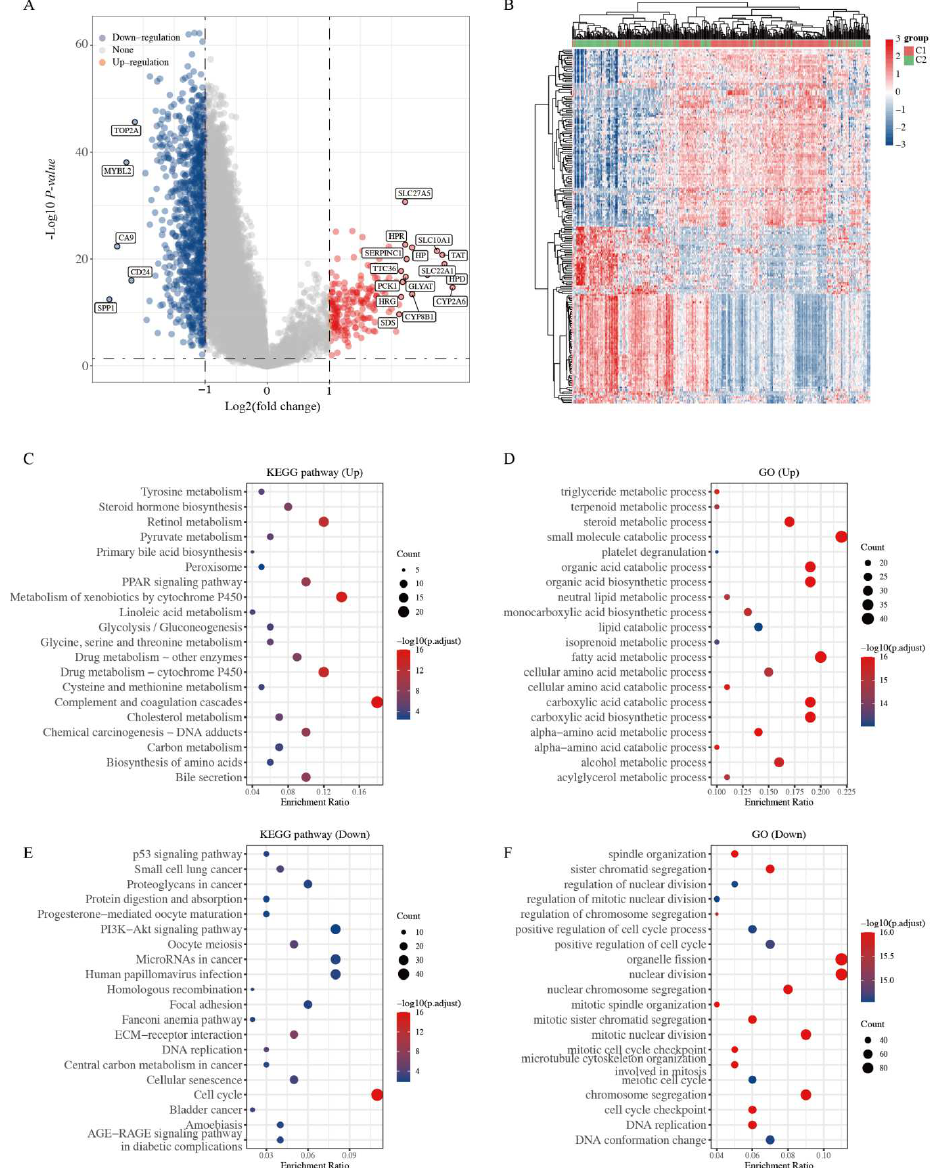
Figure 2. Identification of DEGs between the two clusters grouped by mitophagy-related gene set and functional enrichment analysis. ( A ) Volcano plot of DEGs between two clusters with different mitophagy-related gene expression. The red and blue points represent up- and downregulated genes with statistical significance, respectively. ( B ) Heatmap of the top 50 up- and downregulated genes with the most differential changes. ( C , D ) KEGG/GO analysis of DEGs that were upregulated in cluster 1. ( E , F ) KEGG/GO analysis of DEGs that were downregulated in cluster 1. DEG: differentially expressed genes.